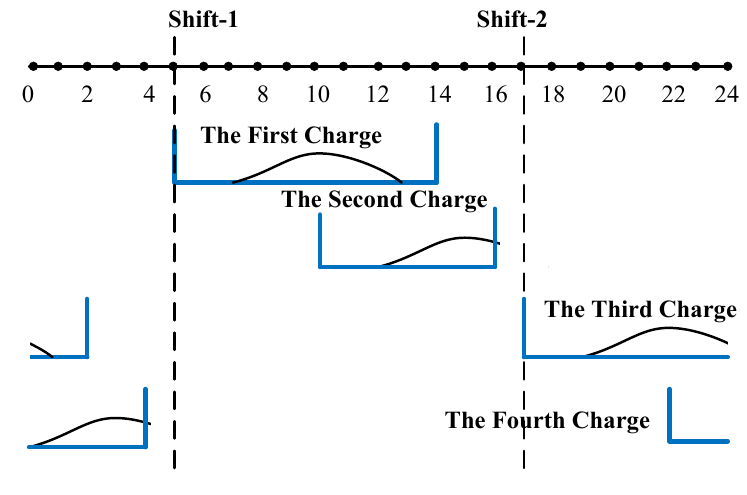
Figure 5. The starting time to charge